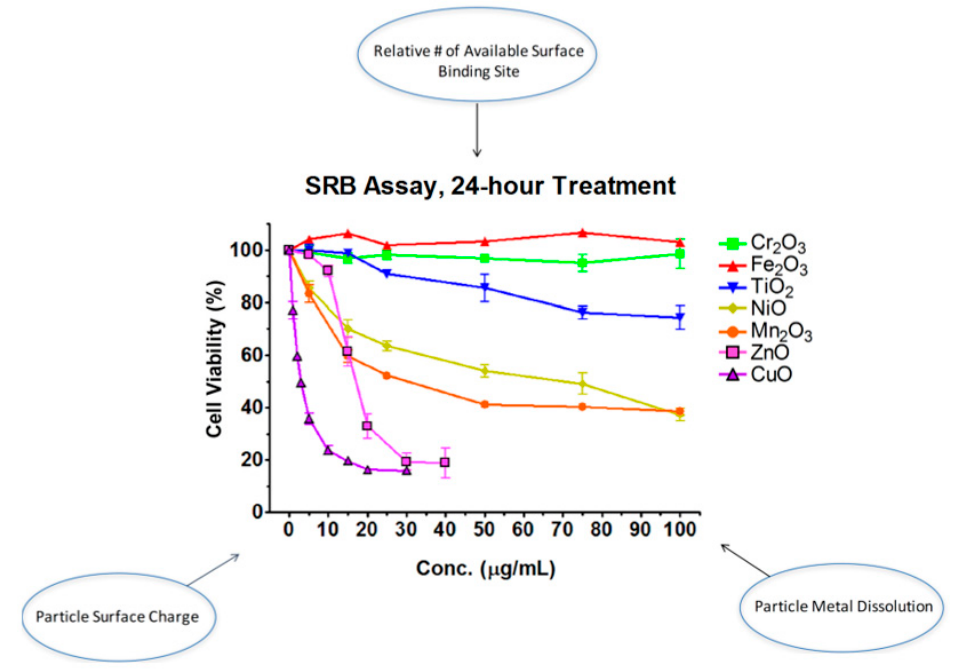
Figure 1. Certain physicochemical parameters of transition metal oxide nanomaterials influence toxicity.